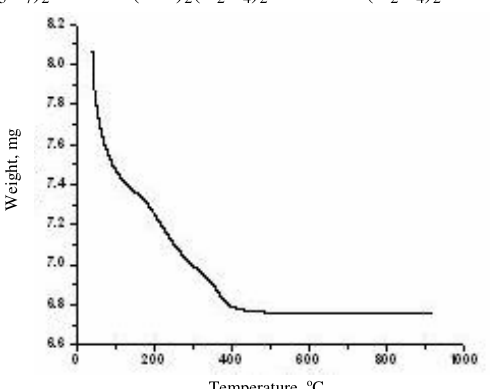
Figure 2. TGA Curve of the citrate complex dried at 90 o C for 12